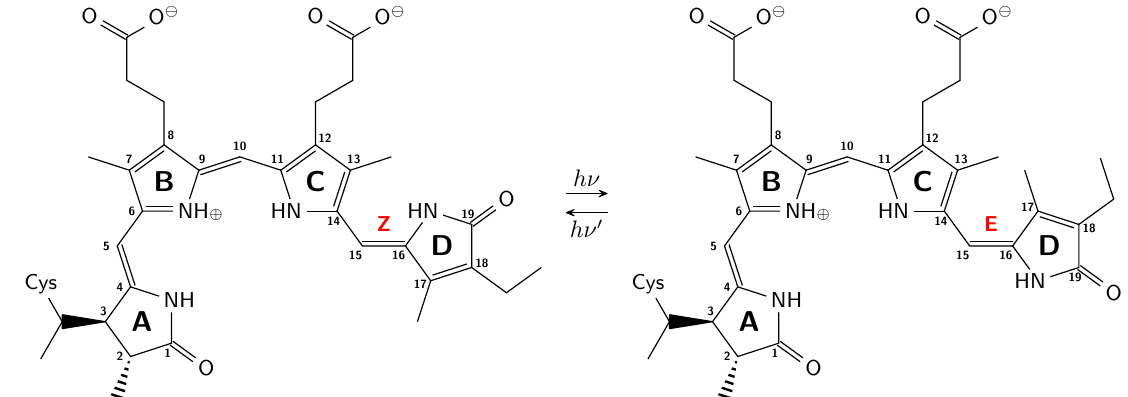
Scheme 1. Structural formula of phycocyanobilin (PCB) in ZZZssa ( left ) and ZZEssa ( right ) configuration. Reversible photoisomerisation of the C 15 –C 16 double bond triggers the